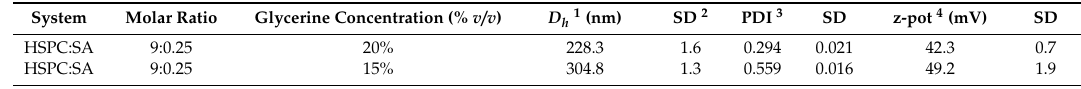
Table 2. The physicochemical properties of reconstituted lipidic vehicles HSPC:SA 9:0.25 with glycerine concentration 20% and 15% v / v after lyophilization and reconstitution.